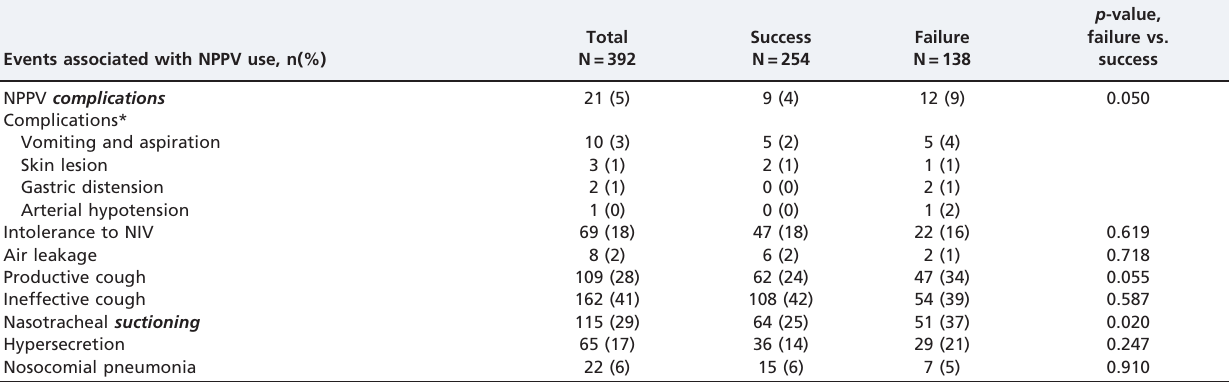
Table 4 - Events associated with NPPV use.